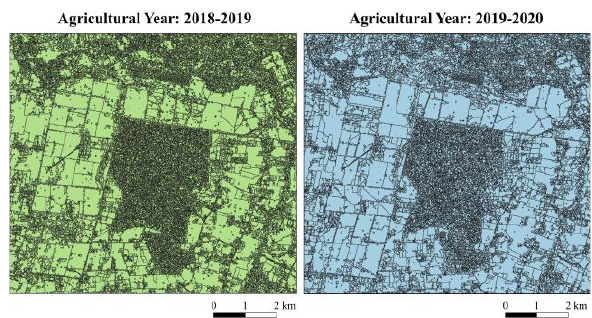
Figure 5. Segmentation of mean images of the spectral bands